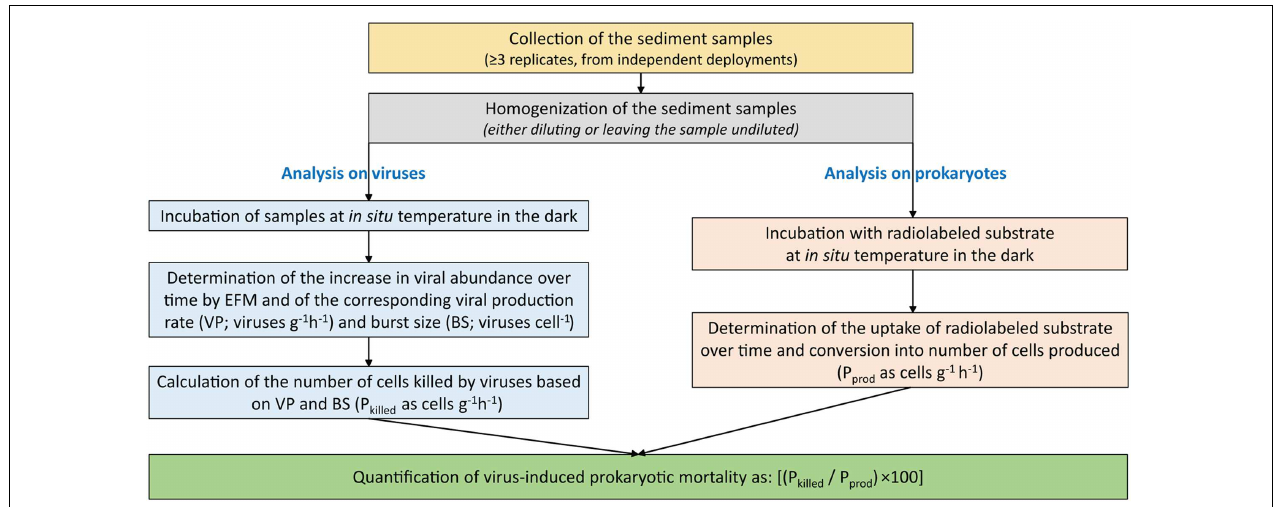
FIGURE 5 | Diagram for the quantification of the viral production in benthic ecosystems. Reported is the flow chart of the different steps required for the analysis of viruses and prokaryotes and the impact of viruses on their hosts. P killed is the number of prokaryotic cells killed by viruses; P prod is the number of prokaryotic cells produced. Details are in the “Materials and Methods”